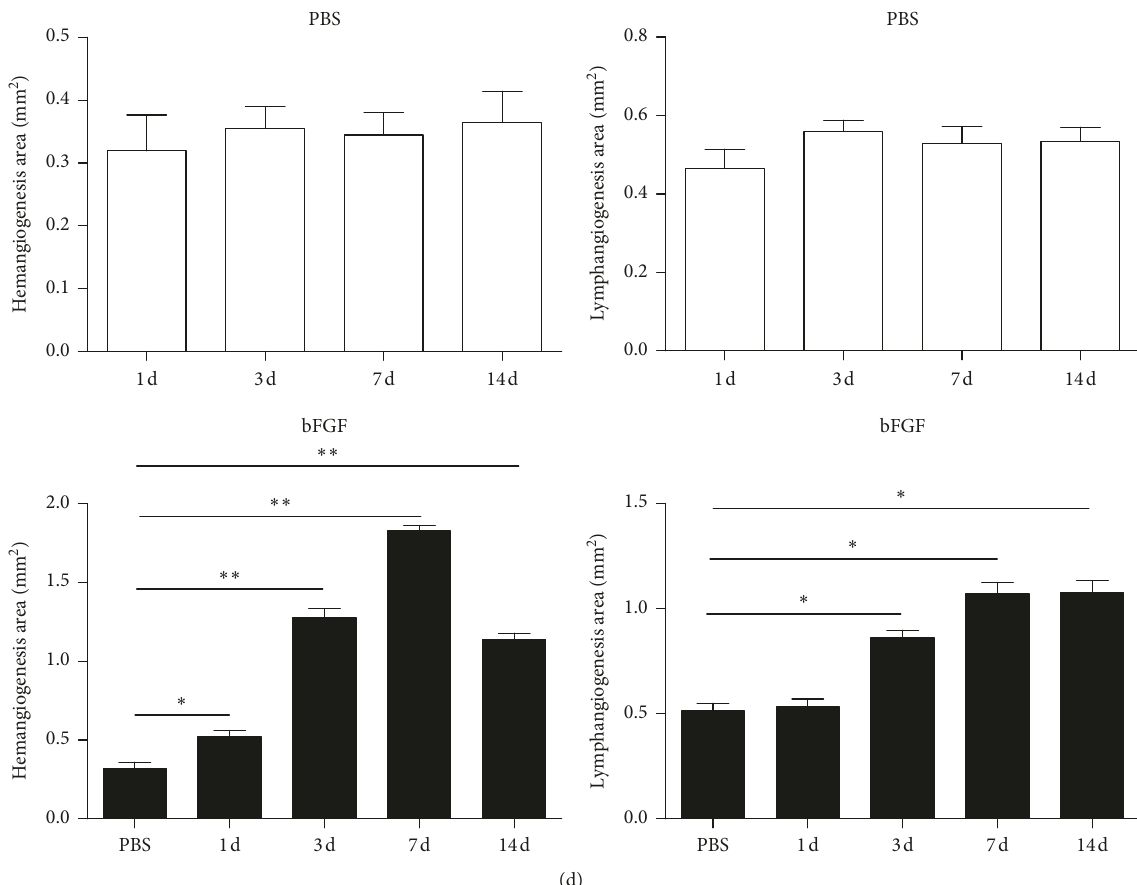
Figure 1: bFGF-induced lymphangiogenesis and hemangiogenesis. (a) Control group: microscopic pictures of corneal neovascularization were examined on days 1, 3, 7, and 14 after PBS pellet implantation ( P vascularization were examined on days 1, 3, 7, and 14 after bFGF pellet implantation ( P was examined on days 1, 3, 7, and 14 after bFGF or PBS pellet implantation ( P lymphangiogenesis and hemangiogenesis on the indicated days after PBS implantation ( n lymphangiogenesis and hemangiogenesis on the indicated days after bFGF implantation ( n